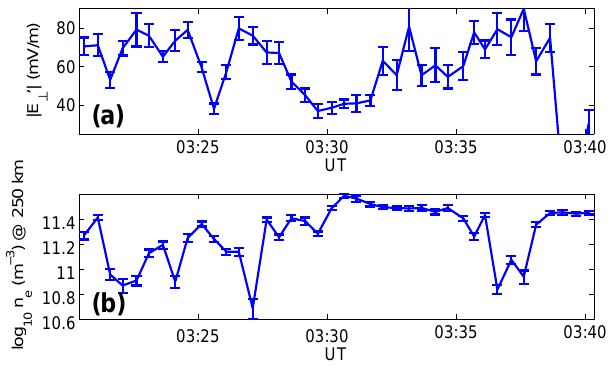
Fig. 8. Plasma depletions associated with variable ion composition. Panel (a) Effective electric field estimated from E-region ion tem- perature. Panel (b) Plasma density in lower